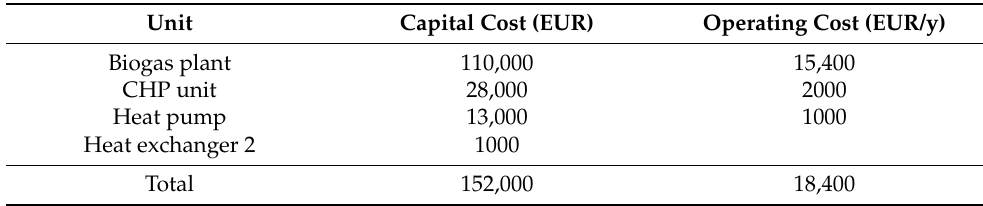
Table 4. Capital and operating cost estimates.